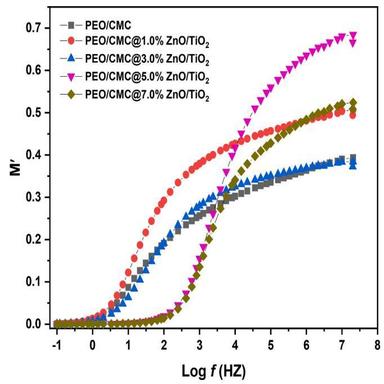
Dependence of Mʹ on frequency for PEO/CMC composite and PEO/ CMC filled 1.0, 3.0, 5.0 and 7.0 wt% of ZnO/TiO2 NPs.